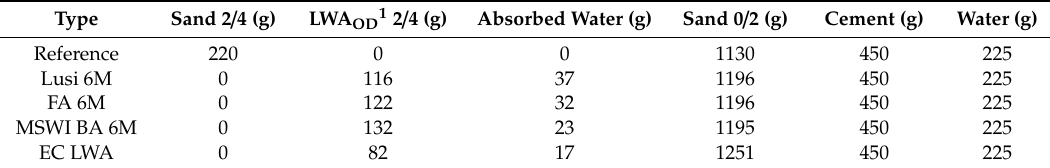
Table 2. Mix design of the mortar.